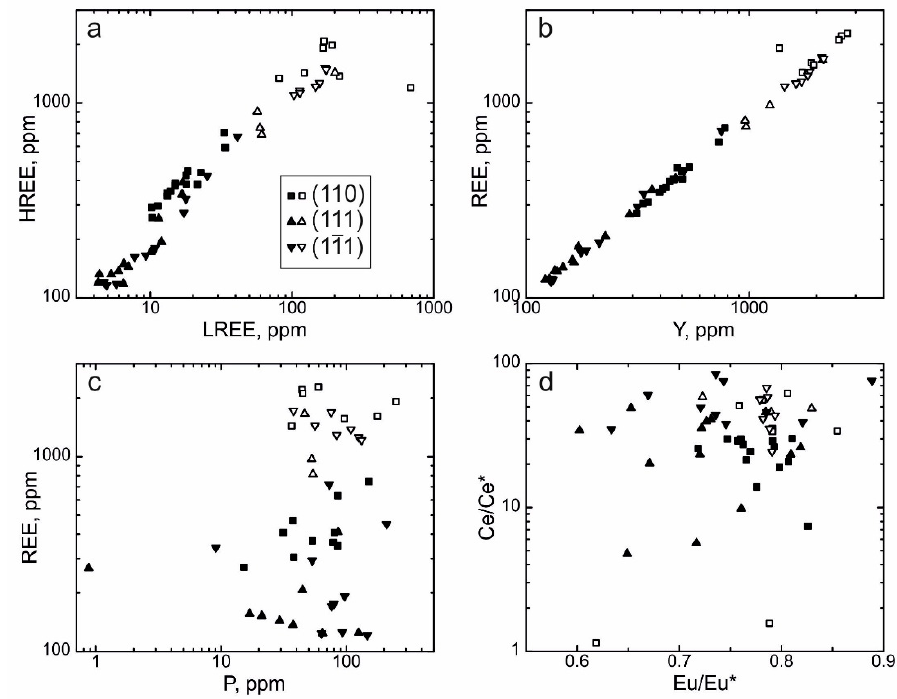
Figure 4. ( a ) LREE versus HREE; ( b ) Y versus REE; ( c ) P versus REE; ( d ) Eu/Eu* versus Ce/Ce* in zircon. Solid symbols correspond the zircon areas which are dark in BSE, open symbols represent the light in BSE zircon areas.